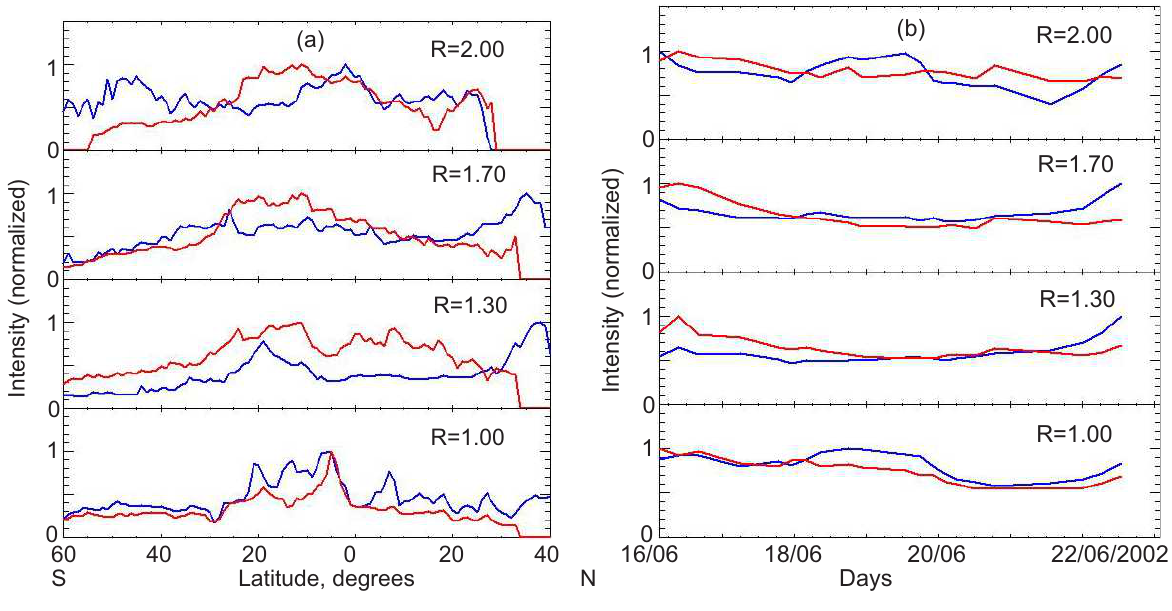
Fig. 7. (a) Latitudinal distributions of the corona brightness above the west limb for 16 June 2002; (b) temporal variations of the corona brightness at different distances along the west equatorial line for the period 16 June 2002...22 June 2002. The blue lines correspond to 175 ˚A, the red lines – to 304 ˚A. The intensities are normalized to the maximum values for each